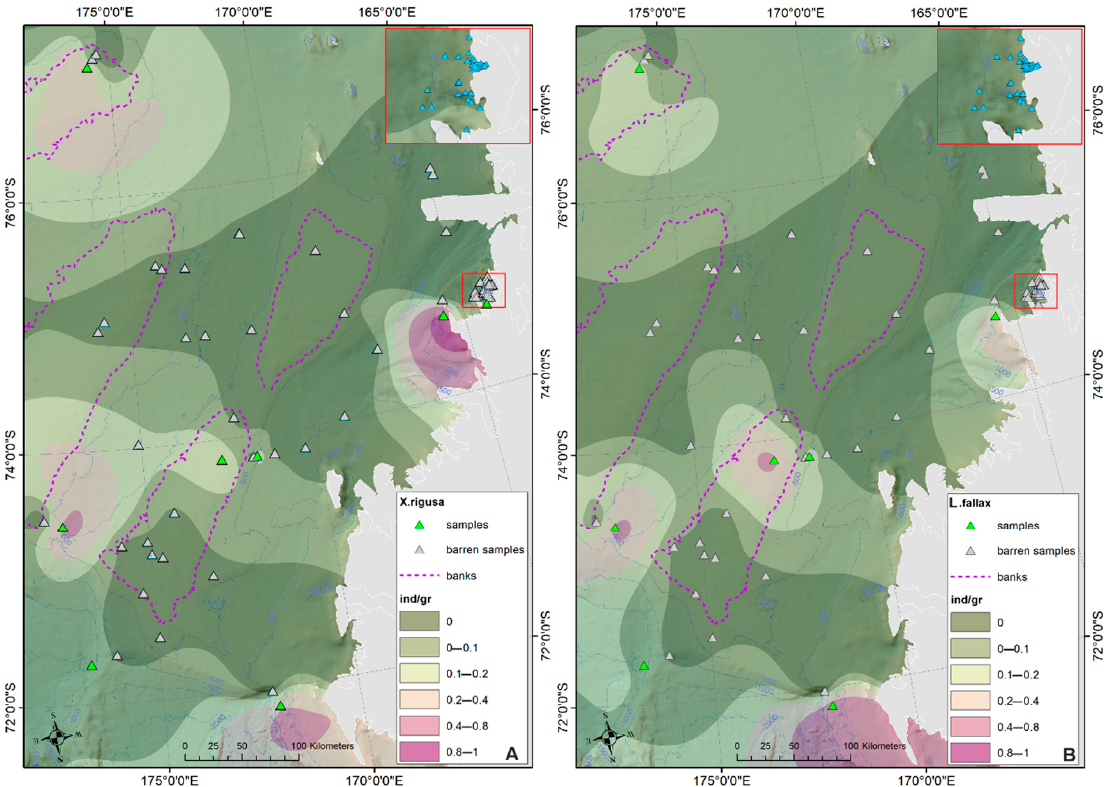
Figure 10. GIS Predictive X. rigusa ( A ) and L. fallax ( B ) distribution maps interpolated in GIS, applying the spline method using barriers. Isobaths every 500 m.